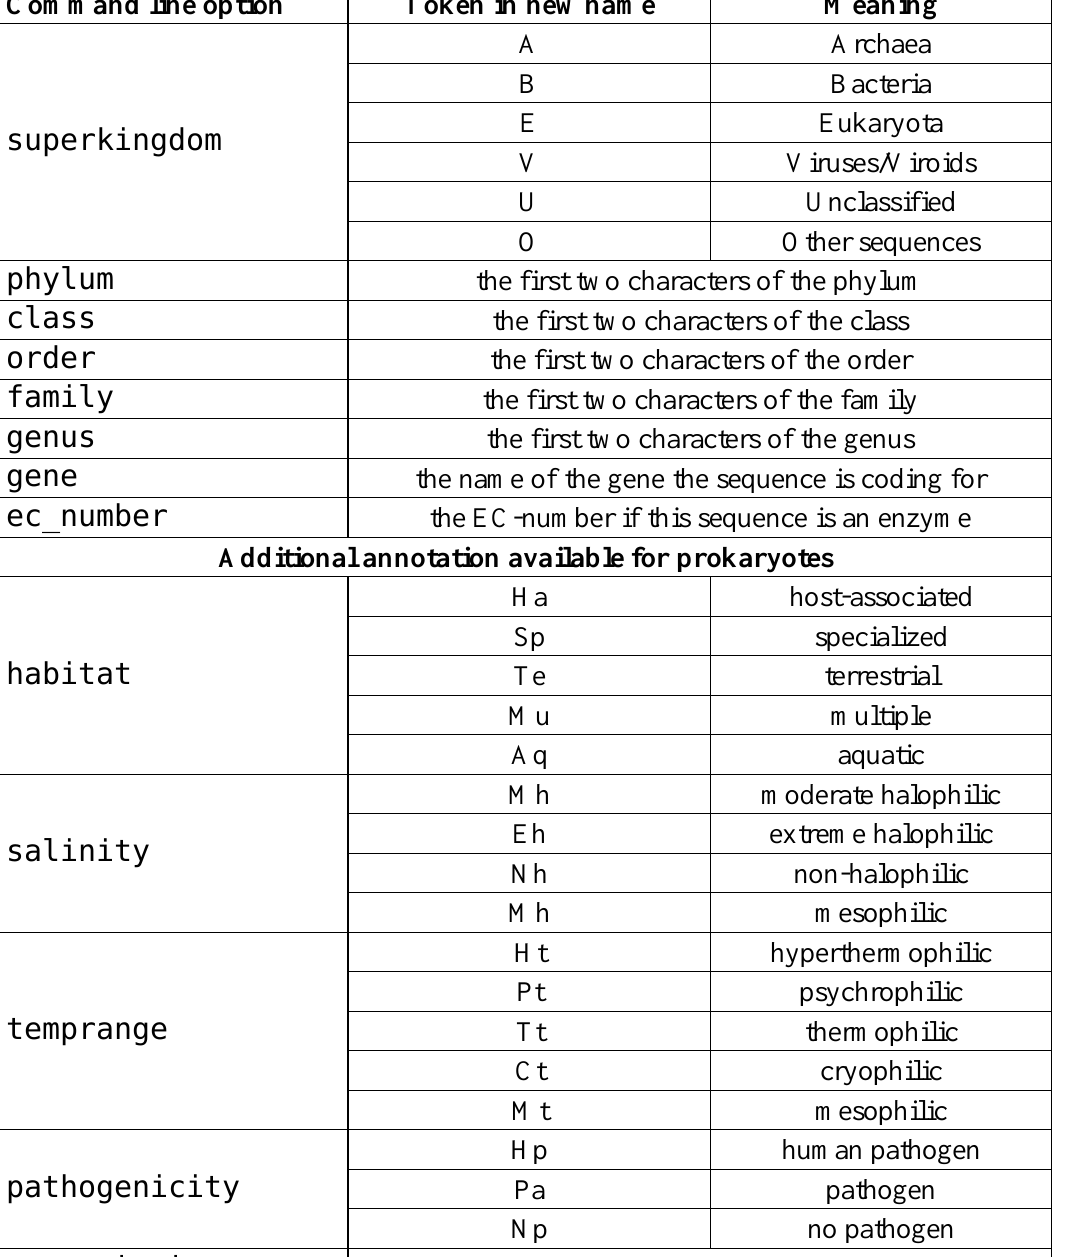
Column 1 lists the command line option. Column 2 gives the resulting infixes which are concatenated to the emerging name. Column 3 lists the meaning of the infixes. Note that the features habitat, salinity, temprange, pathogenicity and gc_content are processed for prokaryotic species only, due to the limited content of the respective data